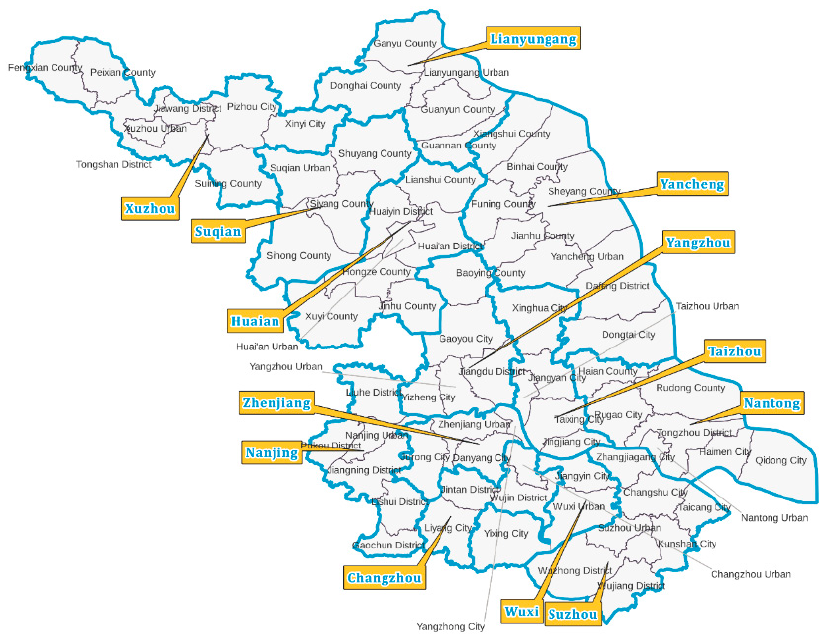
Figure 1. The administrative divisions of cities and counties in Jiangsu. The data are from the China County Statistical Yearbook , China Urban Statistical Yearbook , Jiangsu Province Statistical Yearbook , statistical yearbooks of prefecture-level cities and some existing districts and counties, as well as the regional national economic and Social Develop- ment Statistical Bulletin . The global average production data of each agricultural product come from FAO and Geo remote sensing